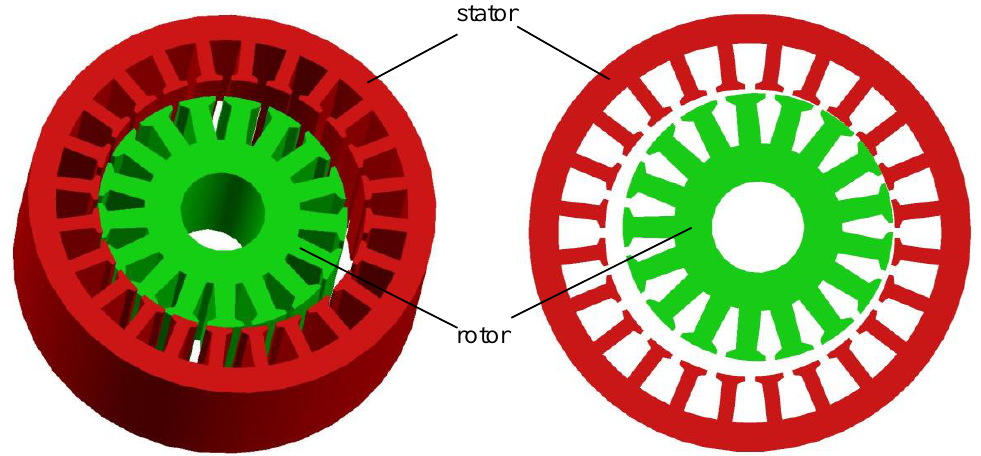
Figure 3. Three-dimensional view and cross section of a zero-airgap induction motor (ZAIM) iron core.